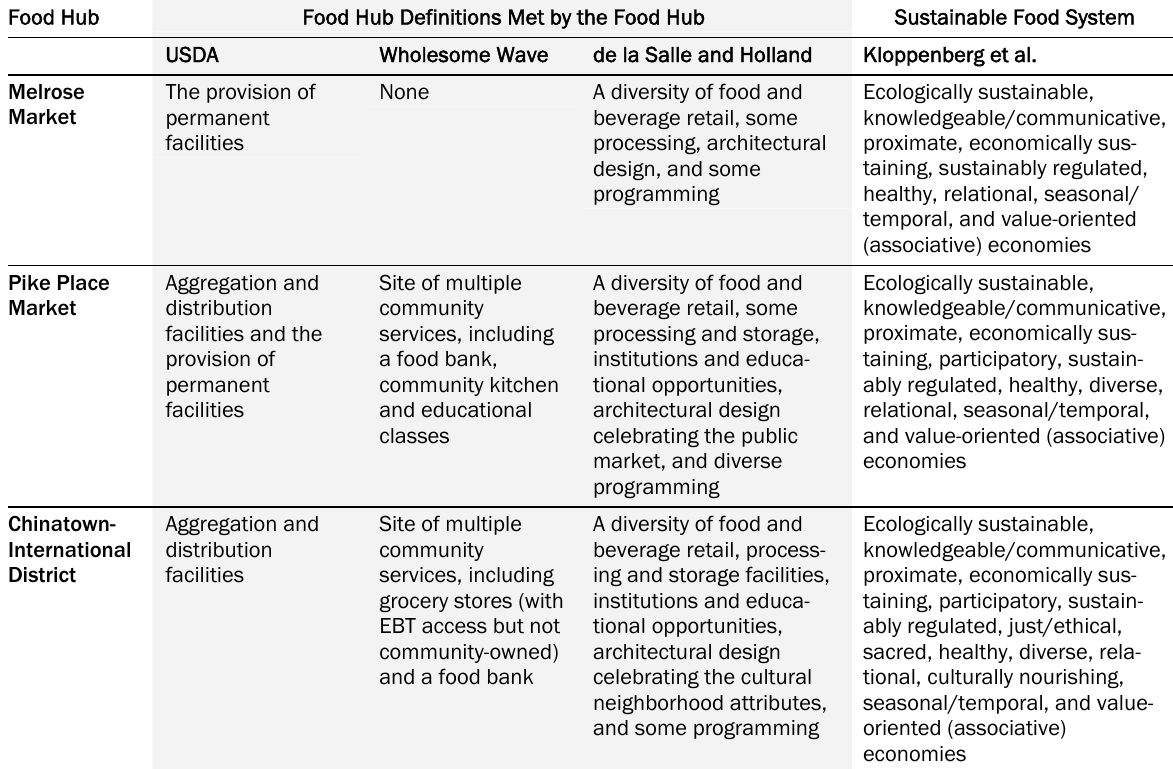
Table 2. Mapping Three Food Hubs to Different